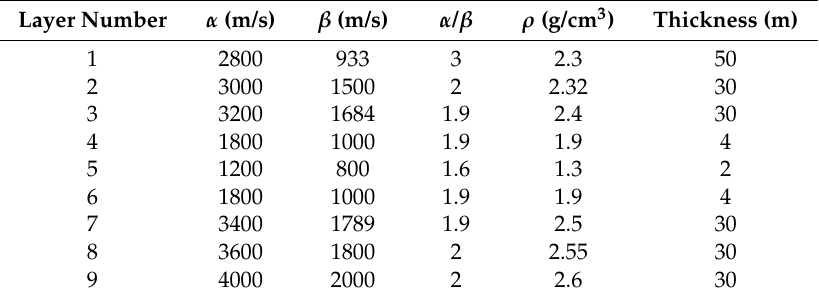
Table 1. Theoretical model parameters of the coal-bearing strata.